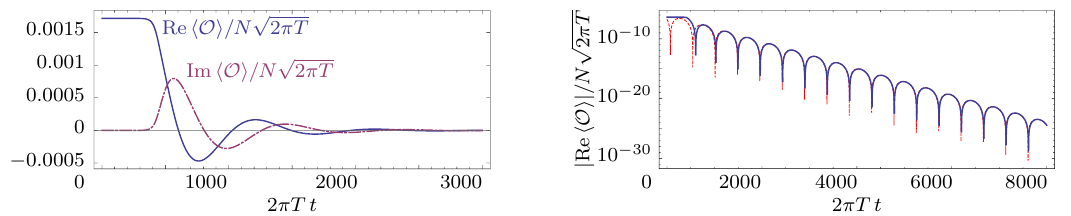
Figure 5. Time evolution of the real and imaginary part of hOi (left), and the absolute value of Re hOi (right) for the condensed-to-normal quench, (cid:20) cn numerical (cid:12)t to the lowest QNM ringdown of the form given by eq. (3.1).